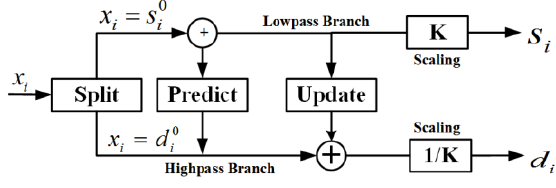
Figure 1. Block diagram of DWT lifting scheme.